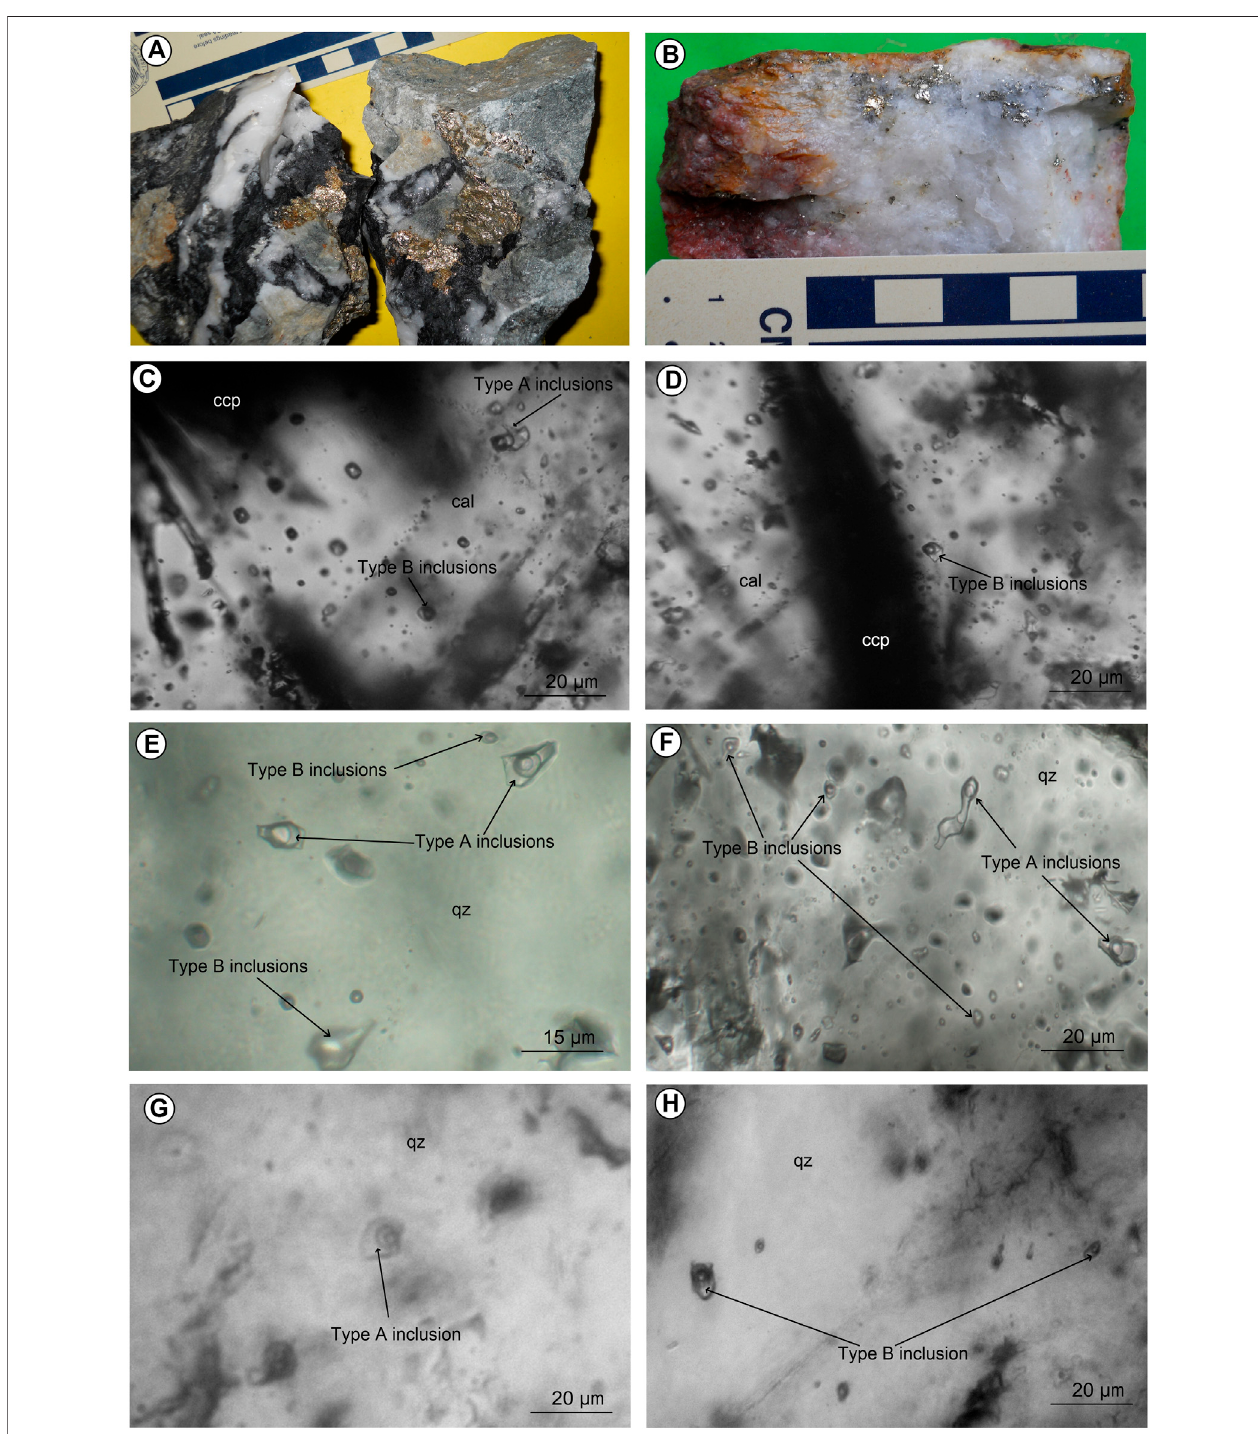
FIGURE 11 | Photographs showing the quartz veins of the deposits. (A) quartz-carbonate-sul fi de vein from Kunzeik, (B) quartz-sul fi de vein from Zibyaung, and photomicrographs (C) and (D) showingTypeA(aqueous-carbonic)andTypeB(aqueous) fl uidinclusionsincalciteofthequartz-carbonate-sul fi deveinfromKunzeik, (E) and (F) showing Type A (aqueous-carbonic) and Type B (aqueous) fl uid inclusions in quartz of the quartz-carbonate-sul fi de vein from Kunzeik, (G) and (H) Type A (aqueous-carbonic)andTypeB(aqueous) fl uidinclusionsinquartzofthequartz-sul fi deveinfromZibyaung.Abbreviations:ccp (cid:1) chalcopyrite,cal (cid:1) calciteandqz (cid:1)